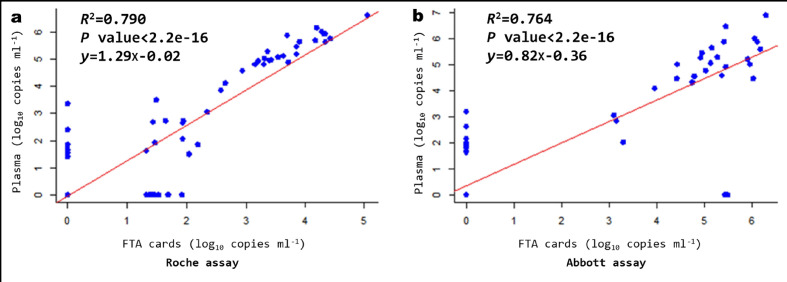
Correlation between FTA cards and plasma specimens in HIV-1 RNA quantitation. The red line indicates the best fit of the data to a linear regression. (a) Using the Roche assay. (b) Using the Abbott assay.